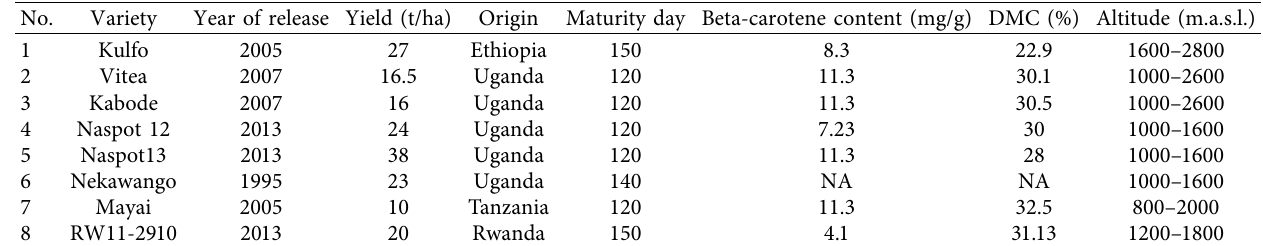
Figure 1: Map of the four testing Table 2: Description of the tested sweet potato varieties in the study areas.